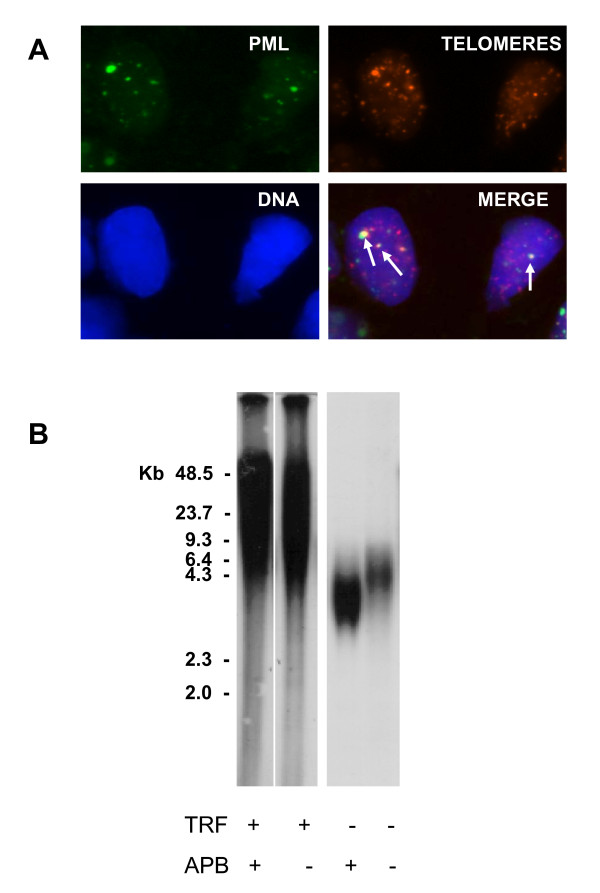
ALT assays in liposarcomas. A) APB assay: combined PML immunofluorescence and telomere fluorescence in situ hybridization (FISH) in a frozen section of an ABP-positive liposarcoma. Indirect immunofluorescence was used for the PML protein (FITC label, green stain). Telomere FISH was done using a Cy3-conjugated telomeric peptide nucleic acid probe (red stain). Nuclei were counterstained with 4',6-diamidino-2-phenylindole (blue stain). The foci of telomeric DNA that co-localize with PML represent APB. B) TRF southern blot analysis. Telomere length distribution of a representative series of liposarcomas. The lengths of telomeres in ALT-positive cells typically range from < 3 to > 50 kb. ALT-negative cells typically have a more homogeneous distribution of telomere length and a shorter average length than ALT-positive cells.